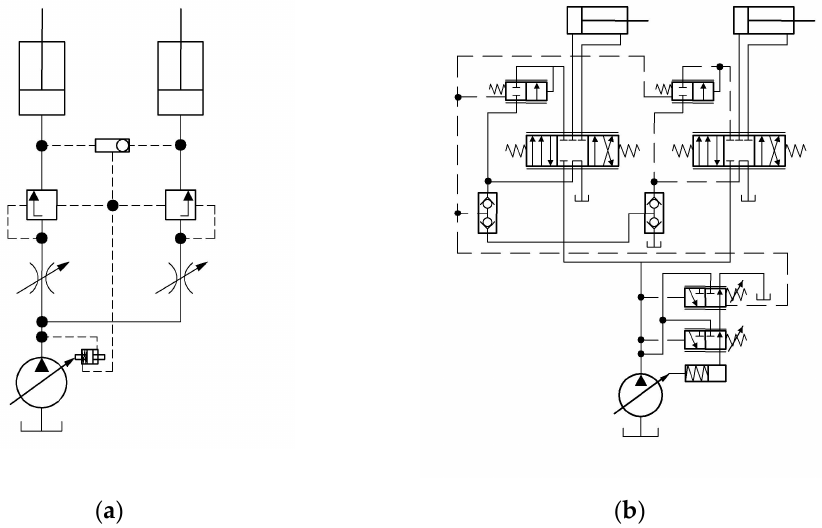
Figure 8. LUDV System Figure. ( a ) Structure of diagram LUDV system figure. ( b ) Schematic diagram of LUDV system.